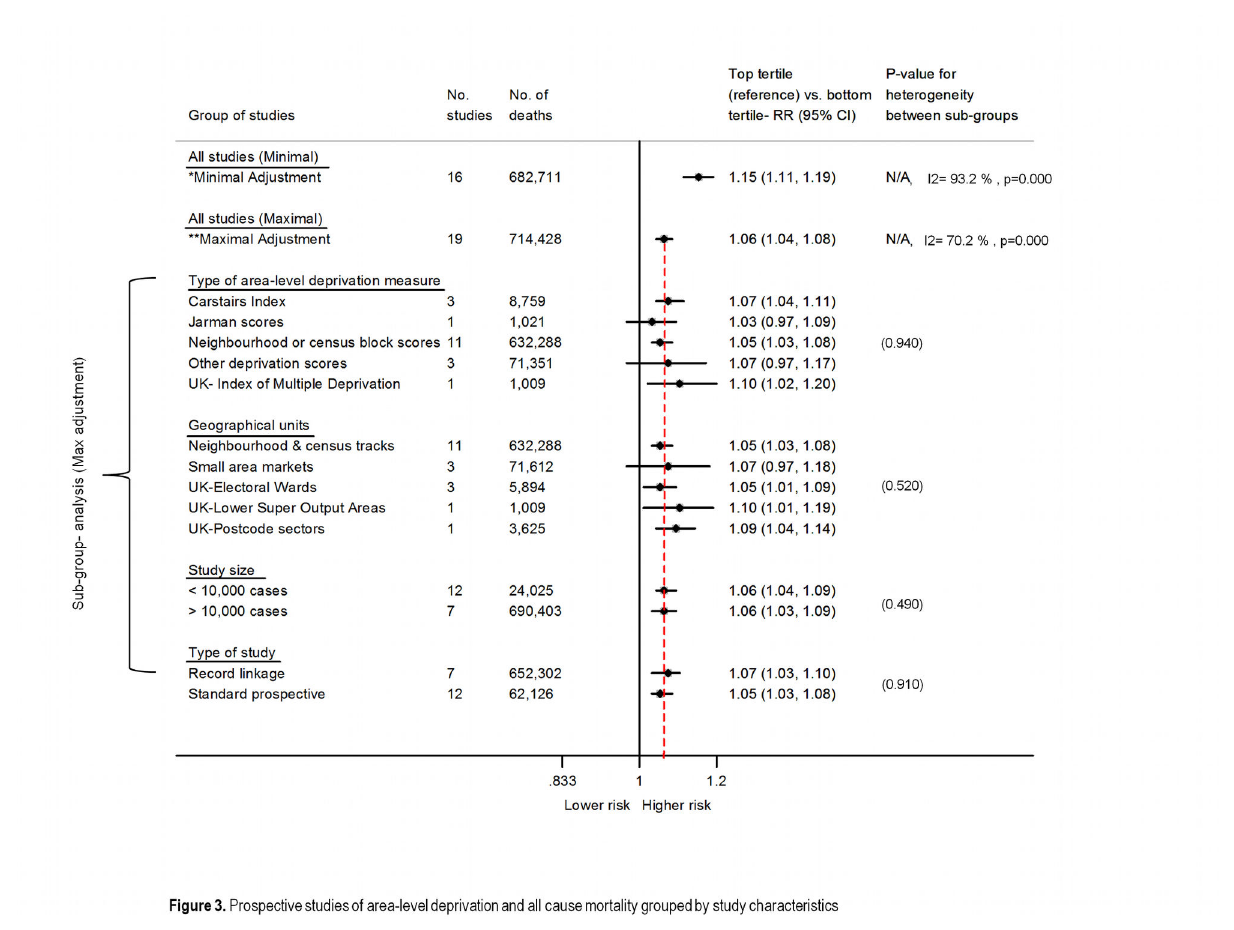
Figure 3. Prospective studies of area-level deprivation and all-cause mortality grouped by study characteristics. For degree of adjustment from individual studies please see Table S7, S8 and Figures S3 and S4 .